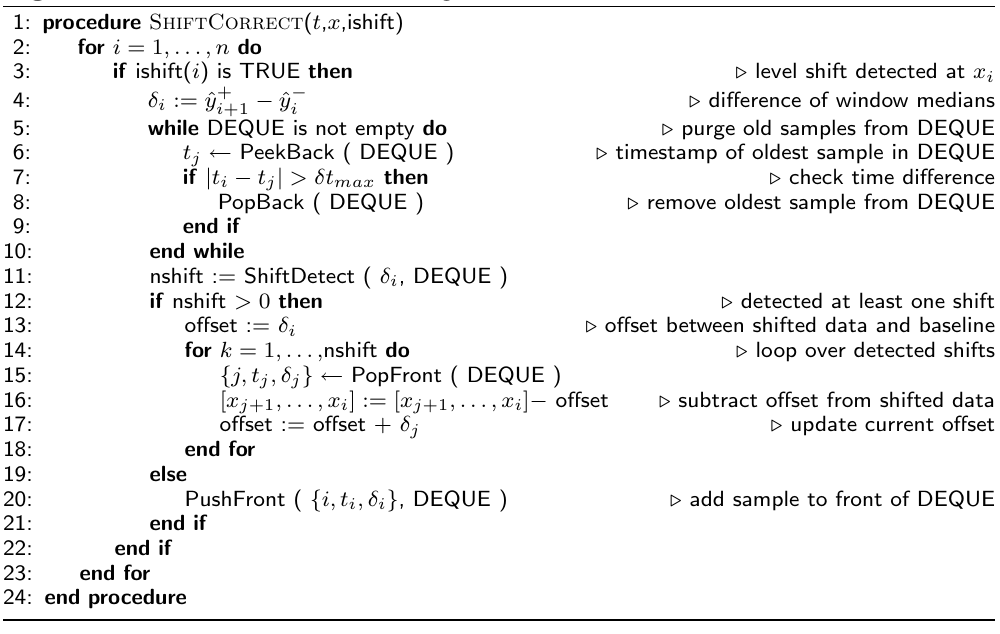
Algorithm 1 Level Shift Correction algorithm